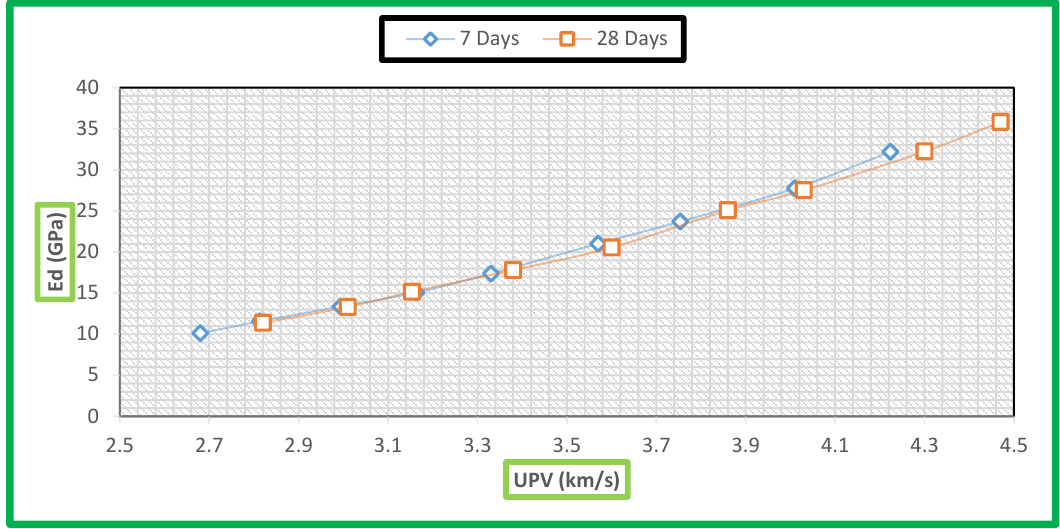
Figure 24. Effect of UPV values on Ed values. Figure 24. E ff ect of UPV values on Ed